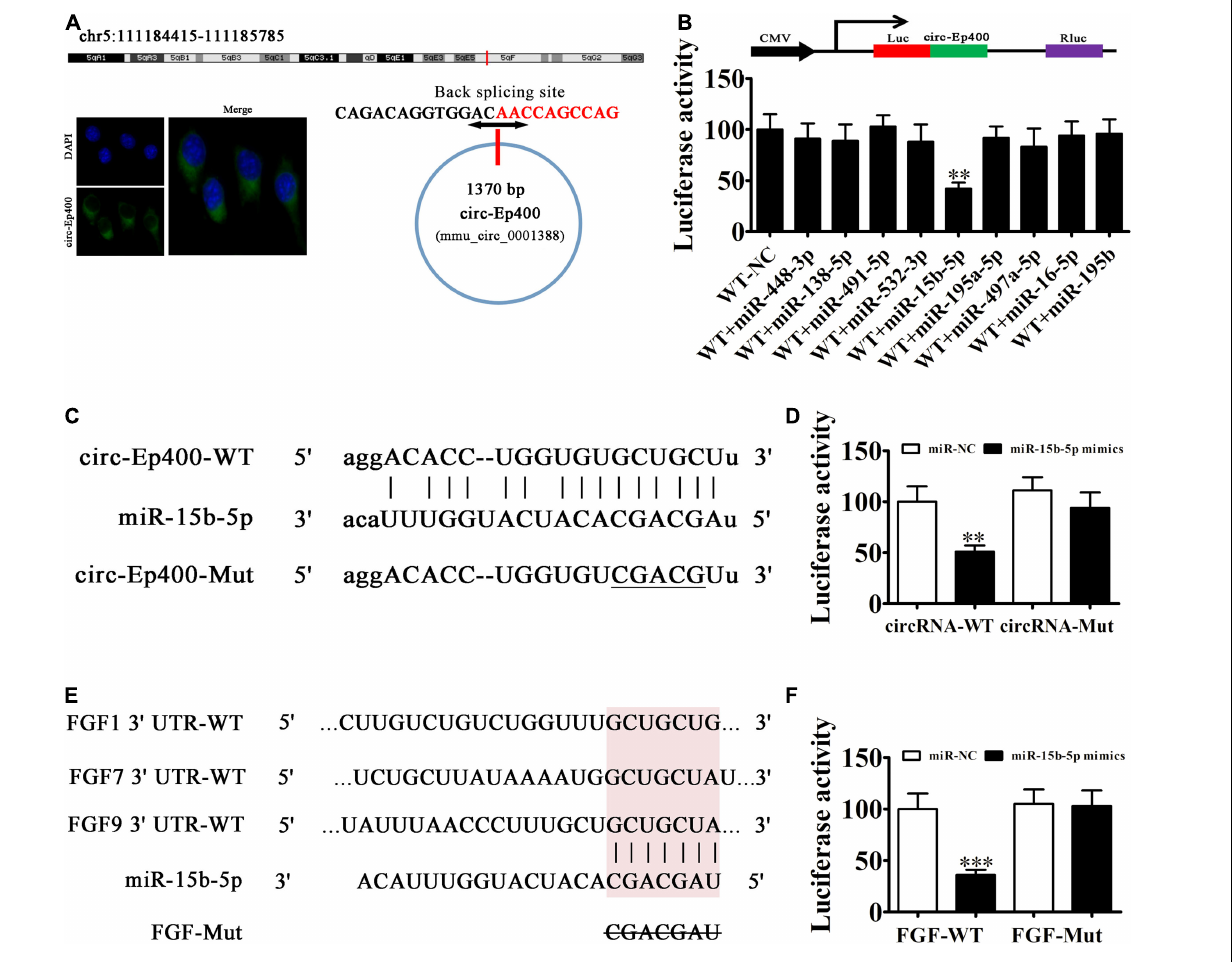
FIGURE 4 | The miR-15b-5p and fibroblast growth factor (FGF) are the downstream targets of circRNA-Ep400. (A) Genomic loci and in situ hybridization was used to localize subcellular circRNA-Ep400. A red signal indicates back splicing. (B) The dual-luciferase reporter assay showing that wild-type and mimic miR-15b-5p co-transfection significantly decreased luciferase activity in HEK293T cells. (C) Prediction of miR-15b-5p binding sites in circRNA-Ep400. The mutant version of circRNA-Ep400 is shown. (D) Relative luciferase activity determined 2 days after HEK293T cell transfection with the miR-15b-5p mimic/NC or circRNA-Ep400 WT/Mut. Data are expressed as the mean ± SD. ∗∗∗ P < 0.001. (E) The miR-15b-5p binding site predictions within the FGF-1/7/9 3 (cid:48) -UTR. The mutant version of 3 (cid:48) -UTR-FGF-1/7/9 is shown. (F) Relative luciferase activity determined 2 days after HEK293T cell transfection with miR-15b-5p mimic/NC or 3 (cid:48) -UTR-FGF-1/7/9 WT/Mut. The results are expressed as the mean ± SD. ∗∗ P < 0.01 and ∗∗∗ P < 0.001.